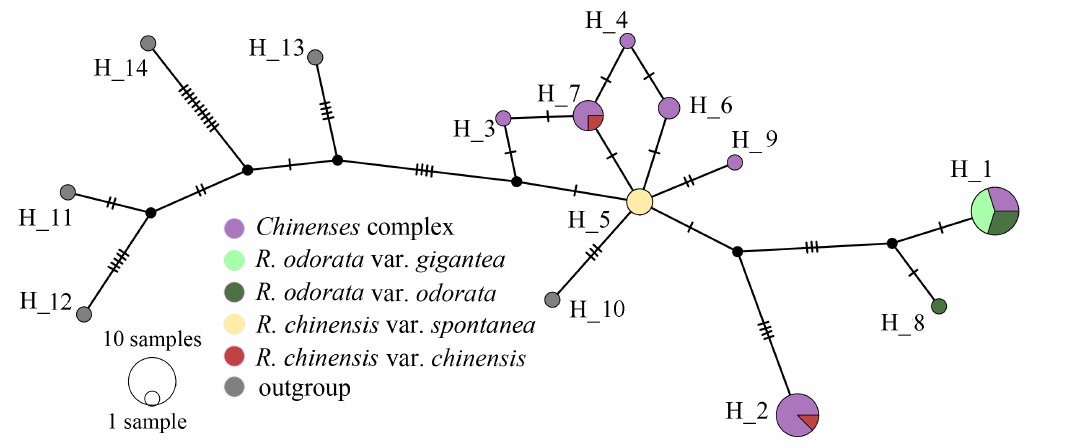
Figure 6. Haplotype network of R . sect. Chinenses based on chloroplast